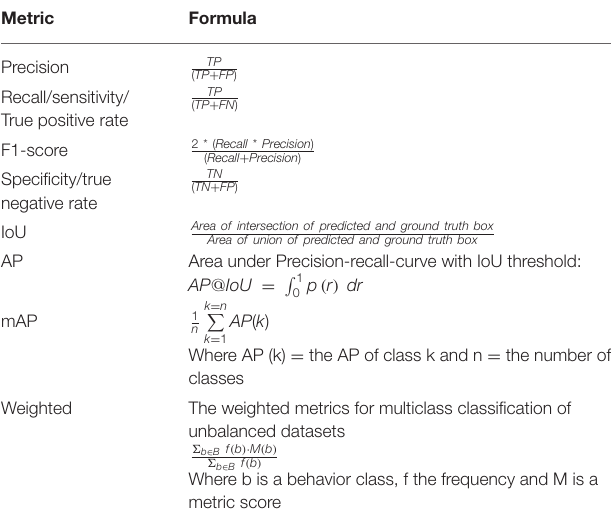
TABLE 2 | Evaluation metrics (TP, true positive; FP, false positive; TN, true negative; FN, false negative). Metric Formula